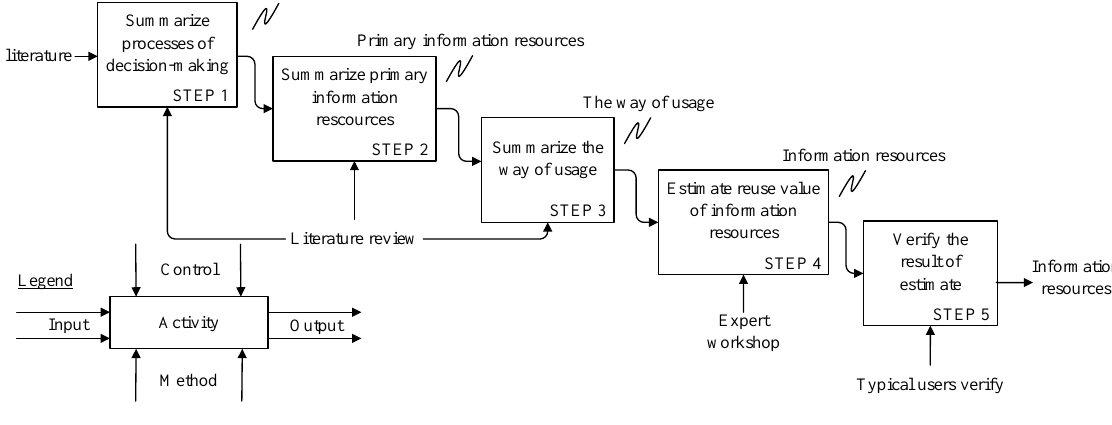
Figure 2 Procedure for the classification and identification of information resource